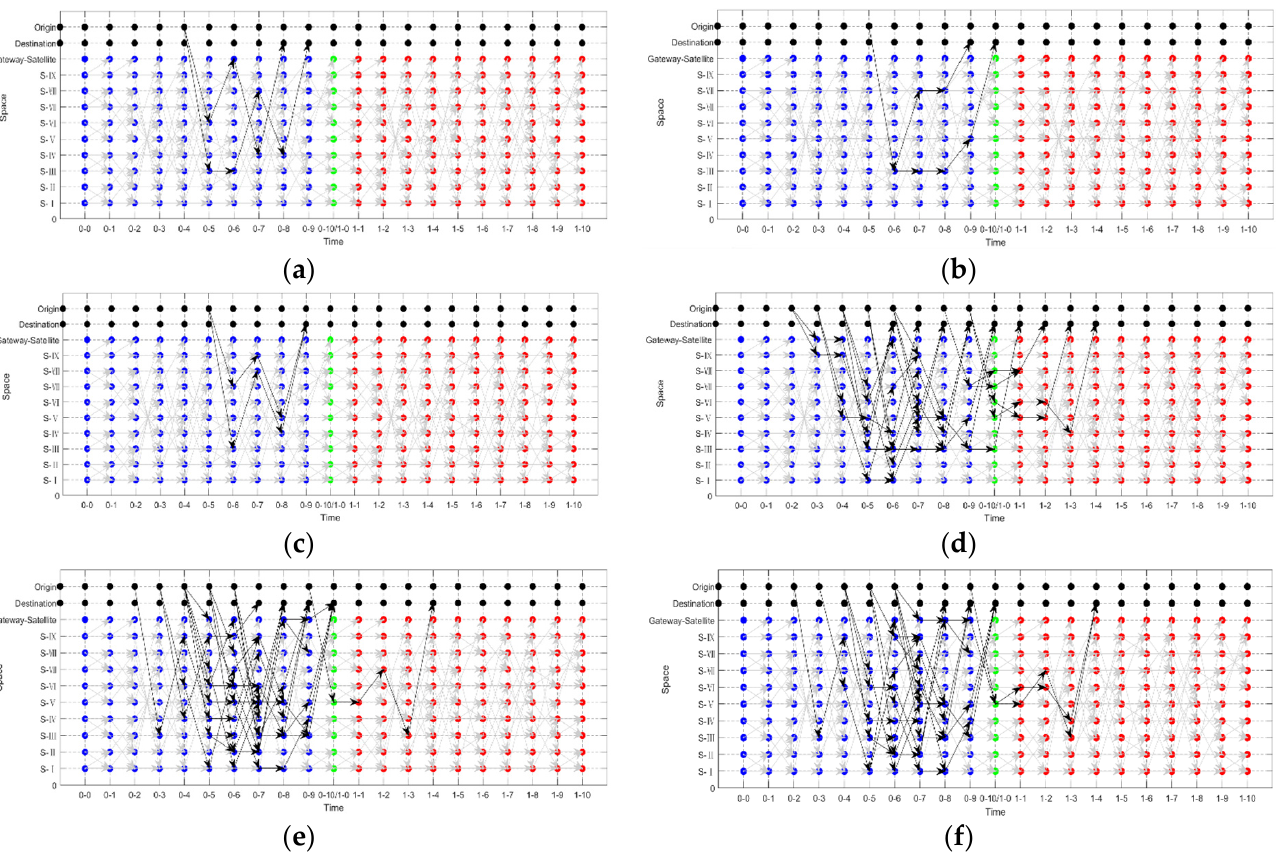
Figure 6. Experimental results for illustrative cases. ( a ) Scenario Ⅰ . ( b ) Scenario Ⅱ . ( c ) Scenario Ⅲ . ( d ) Scenario Ⅳ . ( e ) Scenario Ⅴ . ( f ) Scenario Ⅵ .